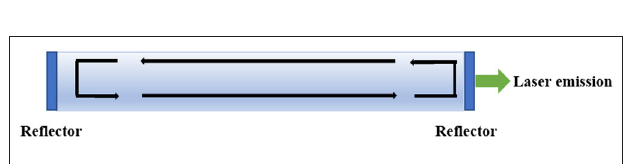
FIGURE 2 | Schematic of nanowire F-P